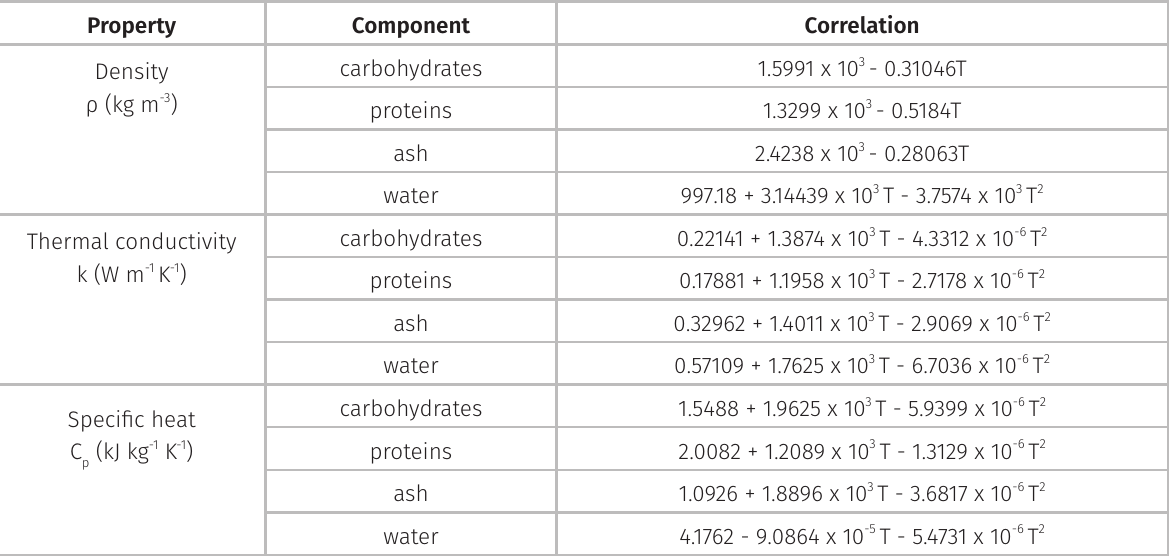
Table V. Correlations for the estimation of thermophysical properties of the majority components of foods. Property